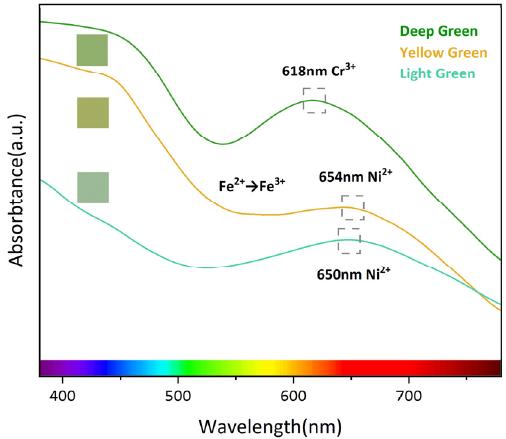
Figure 5. UV-vis absorption spectra of opal in light green, yellow green and deep green. The light green opal shows a wide absorption band centered at 650 nm, which is caused by the 3 A 2g (F) → 3 T 1g (F) electron transition of Ni 2+ . This absorption band is typical of Ni 2+ in the octahedral coordination [26,27]. The results of the green opal test are basically consistent with the previous results of the chrysoprase test [42,43]. A wide transmission window formed between 500–600 nm explains the typical color of the nickel-bearing mineral (apple green). The yellow-green opal has a wide absorption band at 654 nm and moves towards the long wave direction due to the charge transfer of Fe 2+ → Fe 3+ . Yellow- green opal has a lower nickel content than light green opal, and its high iron content is responsible for strong absorption in the near-UV range, giving the opal a greenish-yellow color [44]. With the deepening of green tone, part of the deep green opal UV-vis spectrum shows a wide absorption peak centered at 618 nm, which is caused by the 4 A 2g → 4 T 2g (4F) d–d electron transition of Cr 3+ [45]. Due to Fe 2+ → Fe 3+ charge transfer, a transmission win- mium will darken the color of green opal.